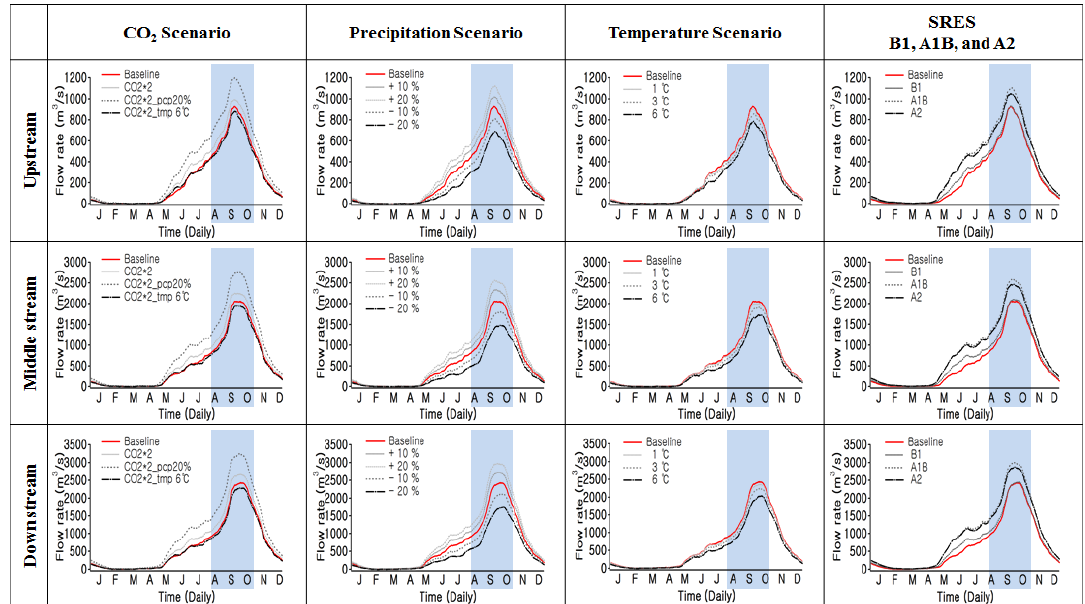
Figure 5. Seasonal variations of the peak stream flow under different climate scenarios in a year. The peak streamflow of each scenario is highlighted in blue to emphasize the difference from the baseline. It includes the upstream, middle stream, and downstream regions of the Chao Phraya